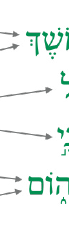
Figure 9: Alignment between the Greek and Hebrew content pools in Gen